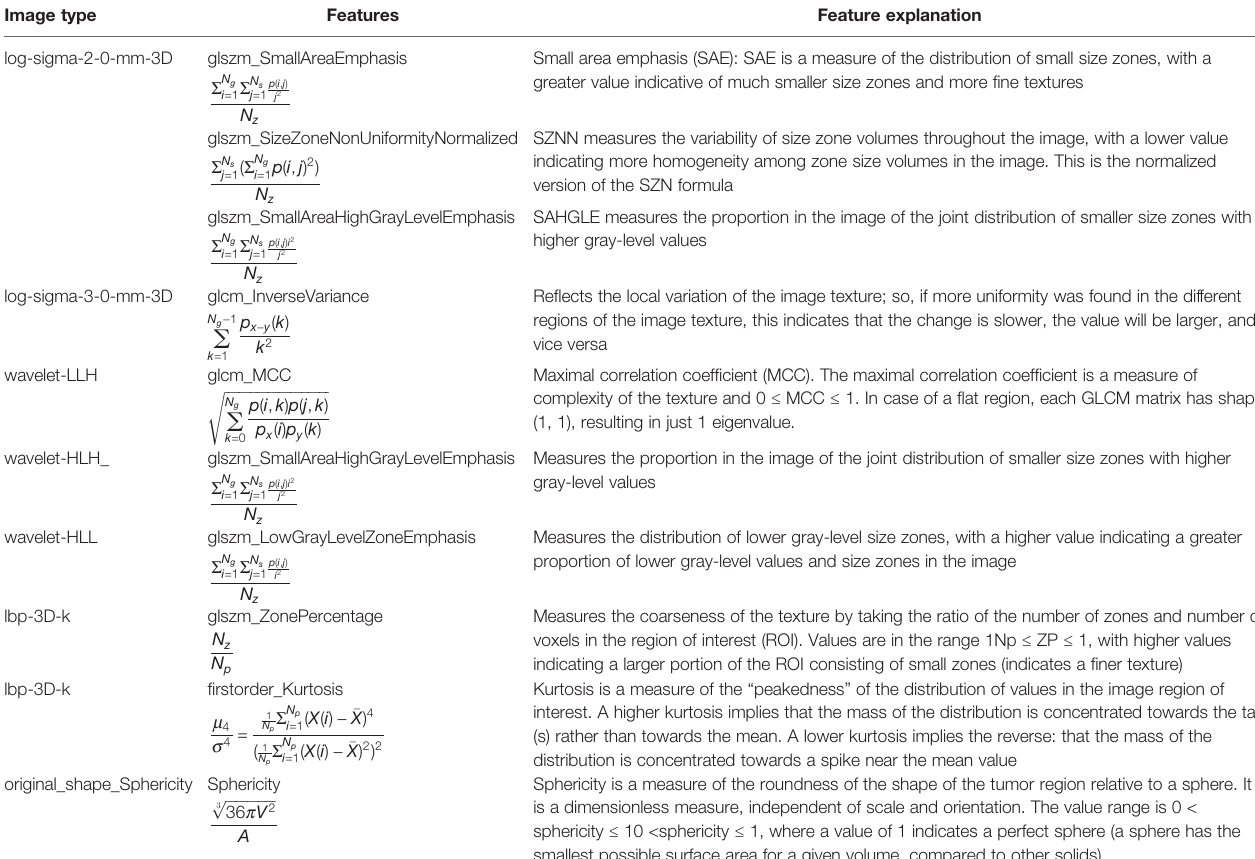
TABLE 3 | Explanation of the texture analysis features.